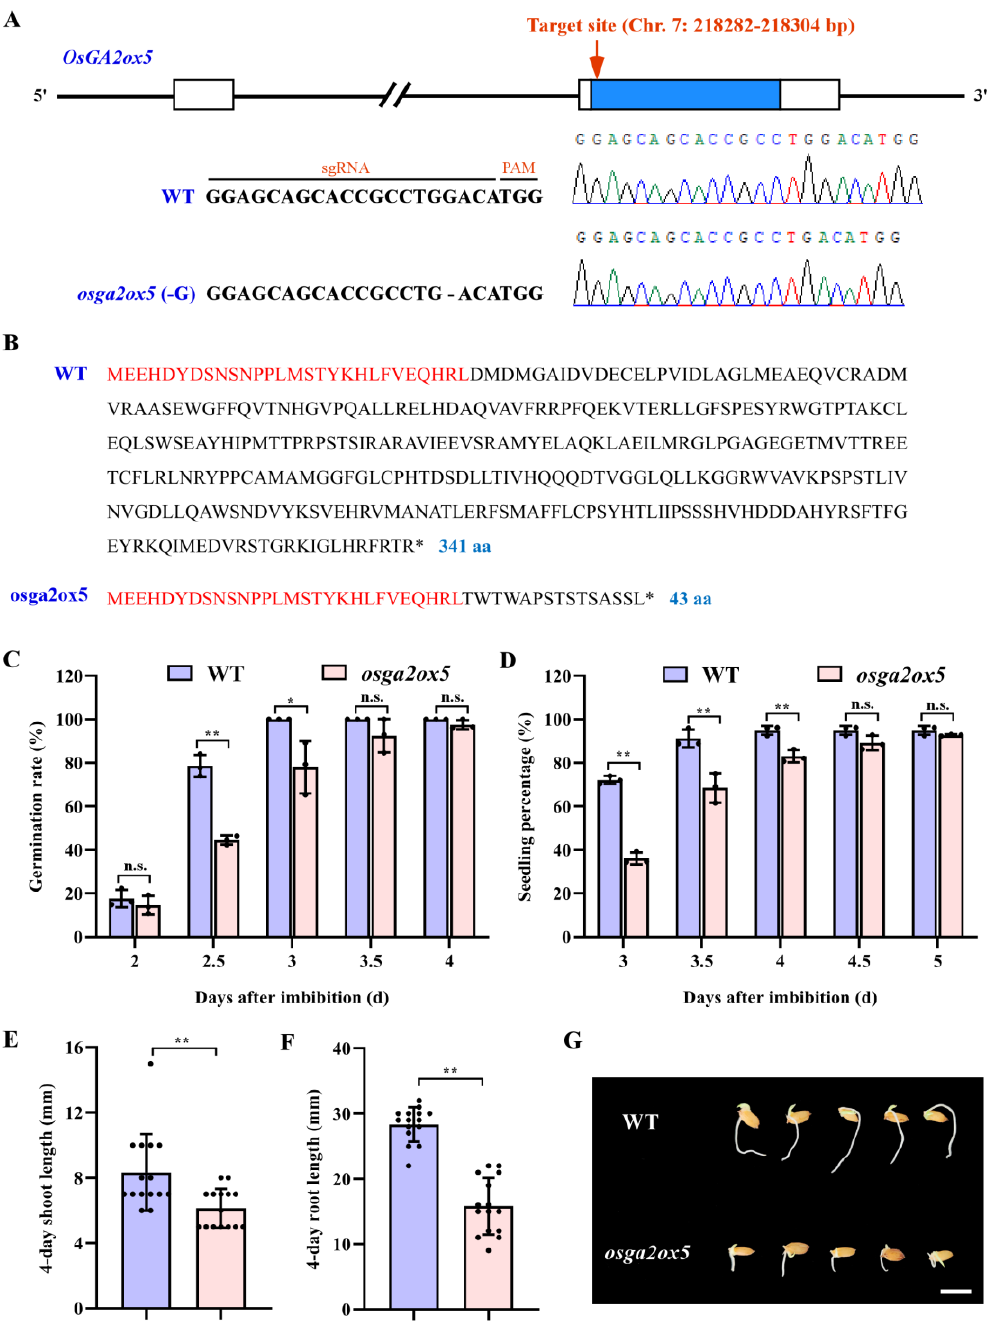
Figure 4. Functional validation of OsGA2ox5 . ( A ) Generation of osga2ox5 mutant using CRISPR/Cas9 system; ( B ) Comparison of inferred amino acid sequences between the WT and osga2ox5 mutant; ( C ) Comparison of germination rate between the WT and osga2ox5 mutant from 2 to 4 days after imbibition; ( D ) Comparison of seedling percentages between the WT and osga2ox5 mutant from 3 to 5 days after imbibition; Comparison of shoot length ( E ) and root length ( F ) between the WT and osga2ox5 mutant at four days after imbibition; ( G ) Germination phenotype of the WT and osga2ox5 mutant at three days after imbibition. Scale bars = 1 cm. Blue rectangle indicates exon; white rectangle indicates UTR. Identical amino acid sequence is highlighted in red. Each black dot represents a technical replicate. Statistical differences between the WT and osga2ox5 mutant were analysed using Student’s t -test. * and ** indicate a significant difference between the WT and osga2ox5 mutant at p < 0.05 and p < 0.01, respectively. n.s., non-statistically significant difference.